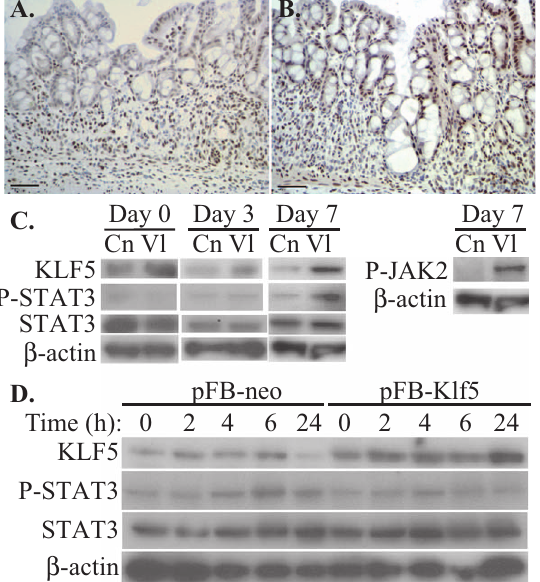
Figure 4. Klf5 overexpression in intestinal epithelia increases STAT3 phosphorylation invivo . ( A, B ) Immunohistochemistry of colonic mucosa from control ( A ) and Villin-Klf5 ( B ) mice following DSS treatment revealed more phosphorylated STAT3 in regenerating colonic epithelial cells from Villin-Klf5 mice. ( C ) Western blot of colonic epithelial scrapings from control (Cn) and Villin-Klf5 (Vl) mice at the indicated time points following DSS treatment revealed increased phospho-STAT3 and phospho-JAK2 in Villin-Klf5 mice at day 7, while phospho-STAT3 was decreased in Villin-Klf5 mice at day 0 and unchanged at day 3. ( D ) Western blots confirmed increased KLF5 expression in IEC-6 cells transduced with pFB-Klf5 compared to pFB-neo. However, following linear wounding, no induction of phosphorylated STAT3 was observed in pFB-Klf5 infected cells, compared to control pFB- neo infected cells. KLF5 protects against the development of colitis in vivo . The